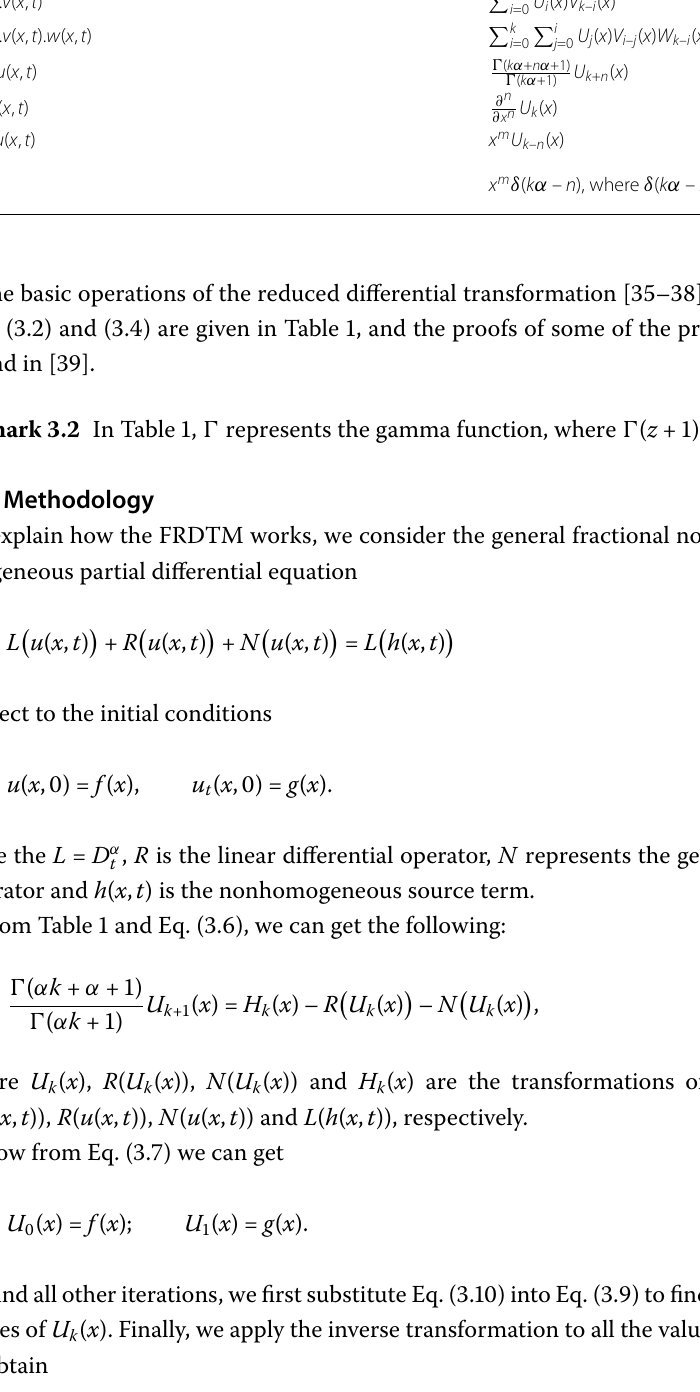
Table 1 Basic operations of the FRDTM [39] Functional form Transformed form u ( x , t